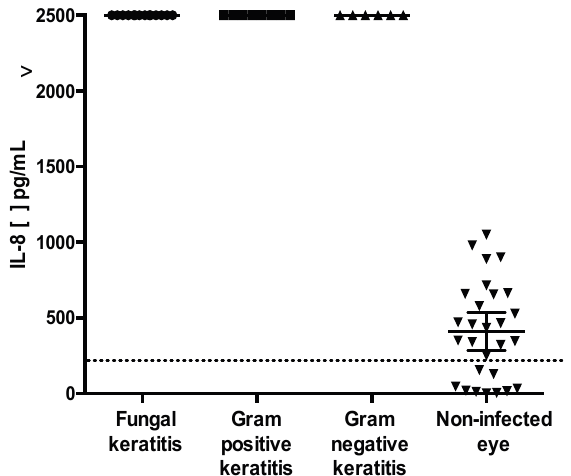
Figure 3. Tears cytokines in patients with microbial keratitis. The proinflammatory cytokines IL-1 β , IL-6 and IL-8, were measured by cytometric bead arrays in tear